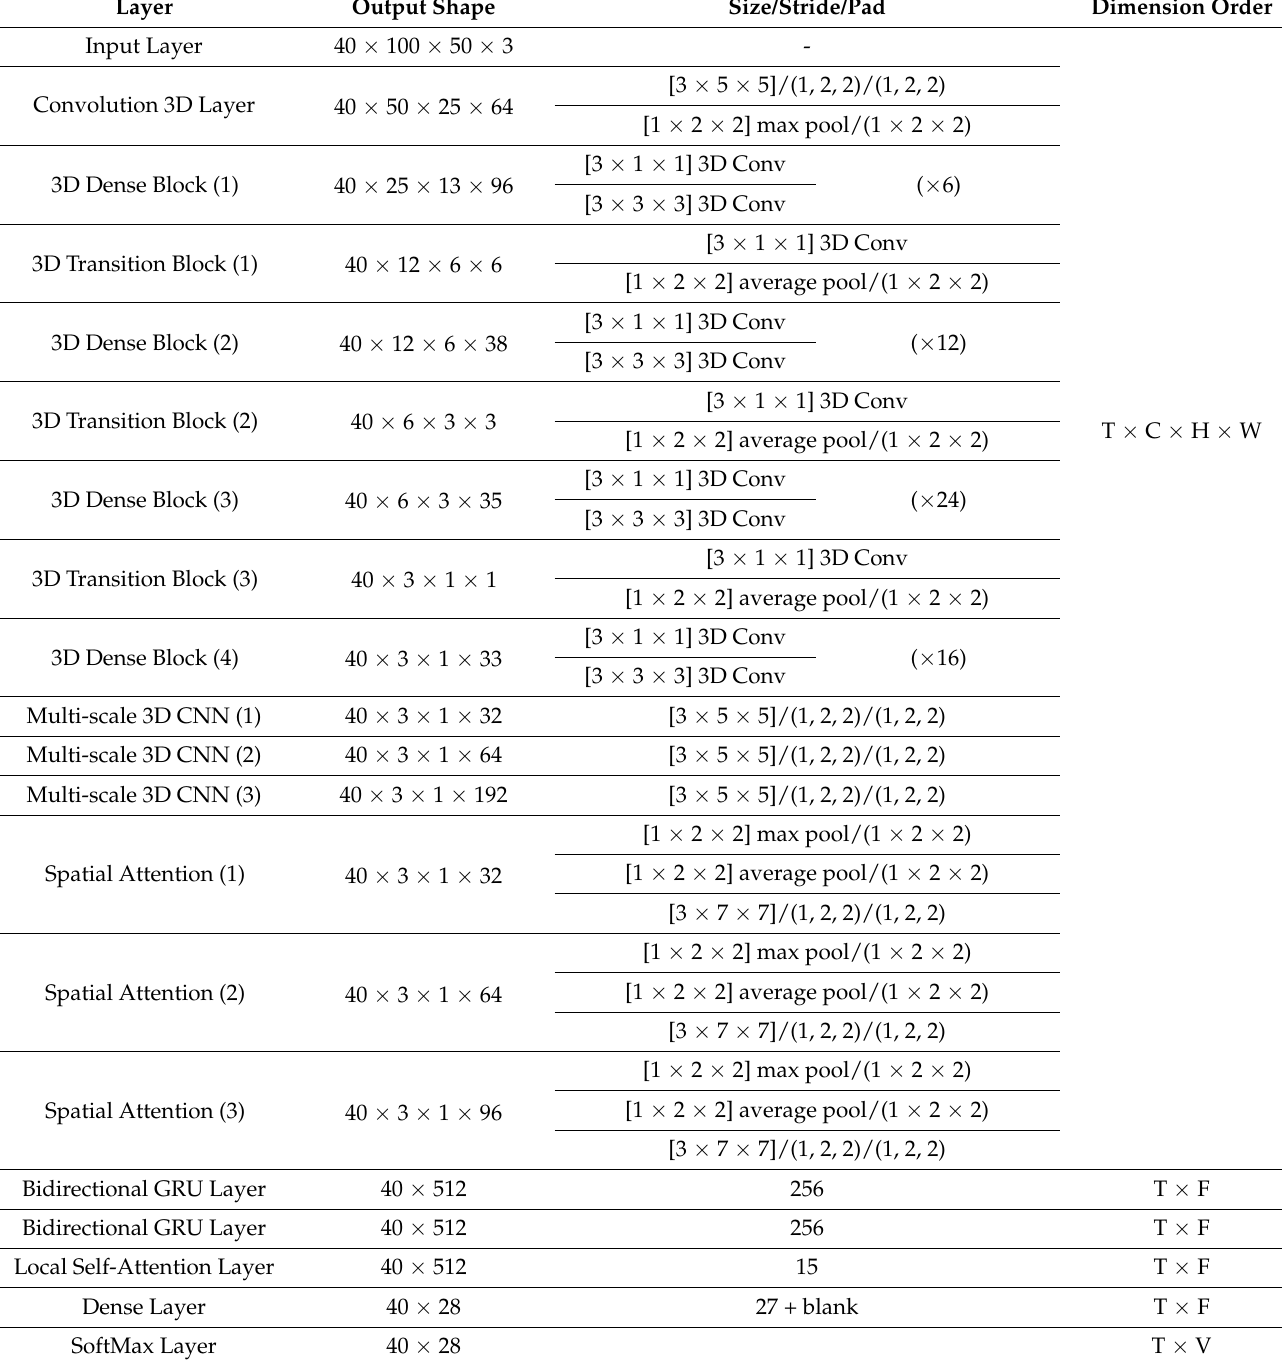
Table 1. Hyperparameters of the proposed